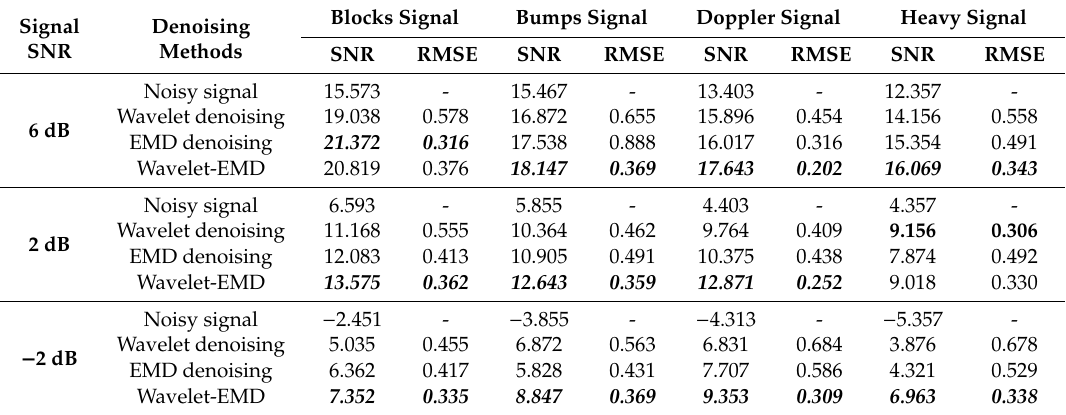
Table 2. Denoising results from the di ff erent methods on signals with di ff erent